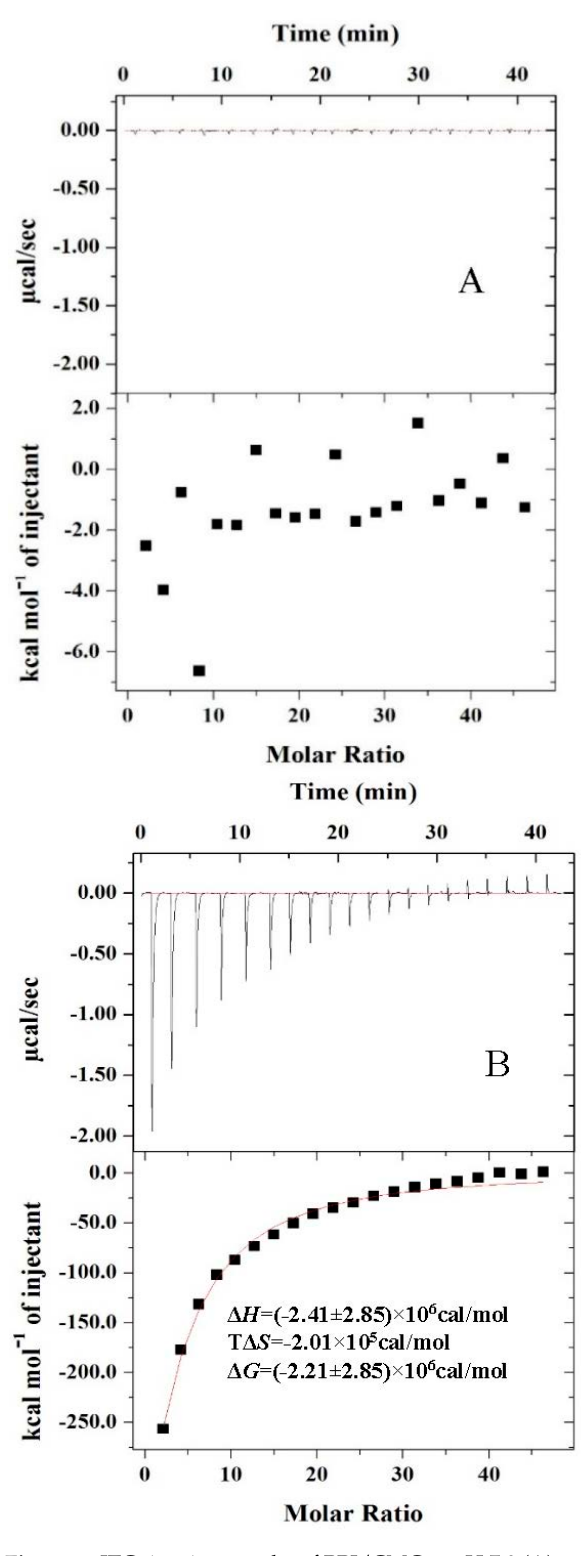
Figure 3. ITC titration graphs of PPI/CMC at pH 7.0 ( A ) and pH 4.5 ( B ). Upper panel: representative raw data as a function of time; lower panel: binding isotherm of enthalpy versus the molar ratio of PPI to CMC, the inserted data were the thermodynamic parameter of binding between PPI and CMC of pH 4.5 ( B ). CMC solution (2.31 × 10 − 7 mol/L) was loaded in the calorimetric cell and PPI solution (5 × 10 − 5 mol/L) was loaded in the syringe.